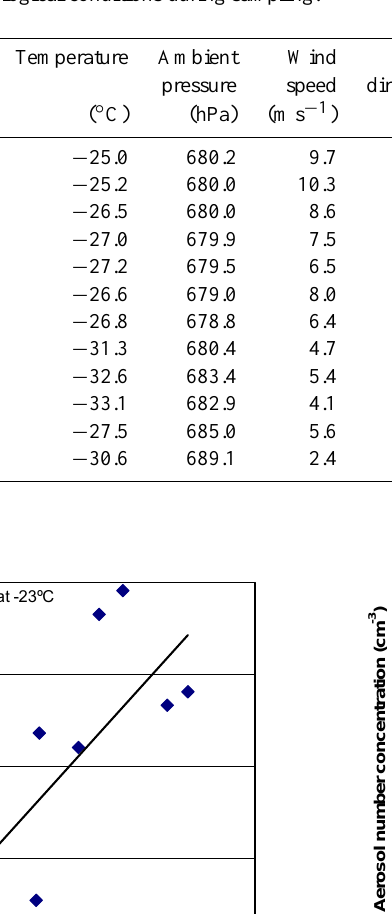
Table 3. Average surface meteorological conditions during sampling.